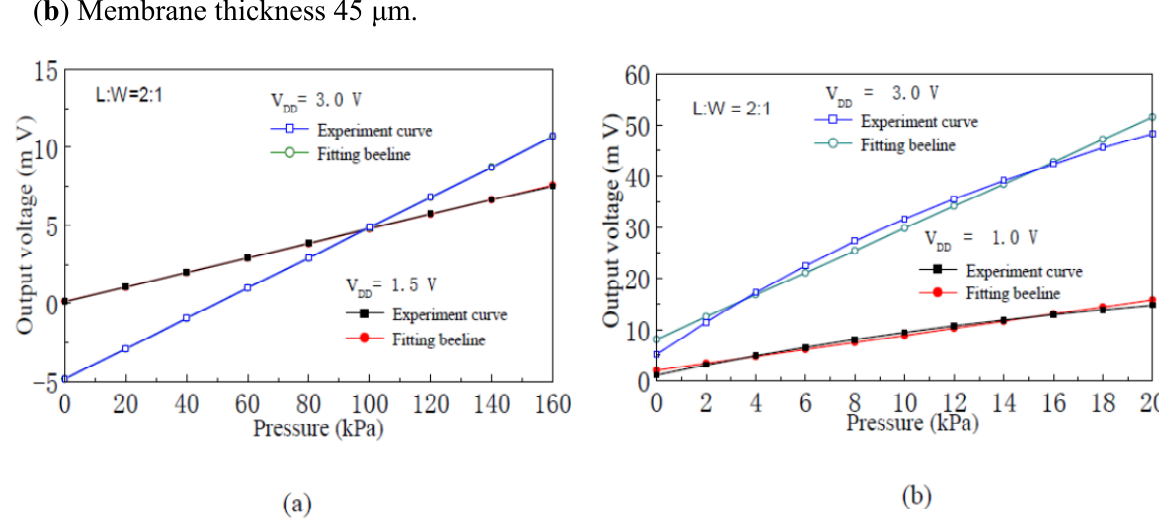
Figure 8. Input-output characteristics fitting beelines and experimental curves of the nc- Si/c-Si heterojunction MOSFETs pressure sensor. ( a ) Membrane thickness 75 μ m; ( b ) Membrane thickness 45 μ